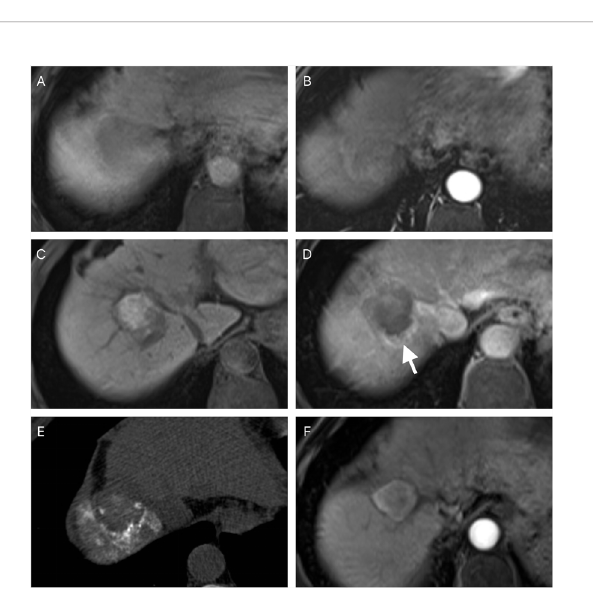
FIGURE 2 | Survival curves in progress-free survival (A, C) and overall survival (B, D) of patients with fi rst attempt complete ablation and incomplete ablation before and after a one-to-one propensity score-matching.